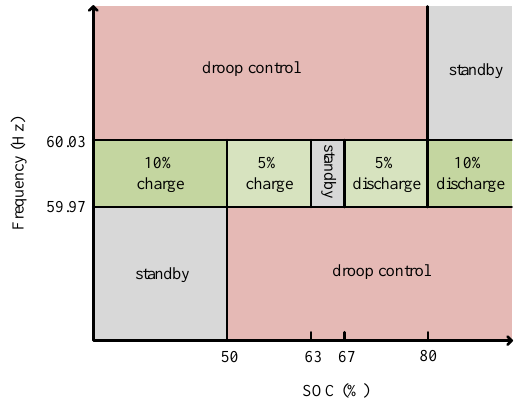
Figure 3. ESS operation mode according to the frequency and state of charge (SOC).